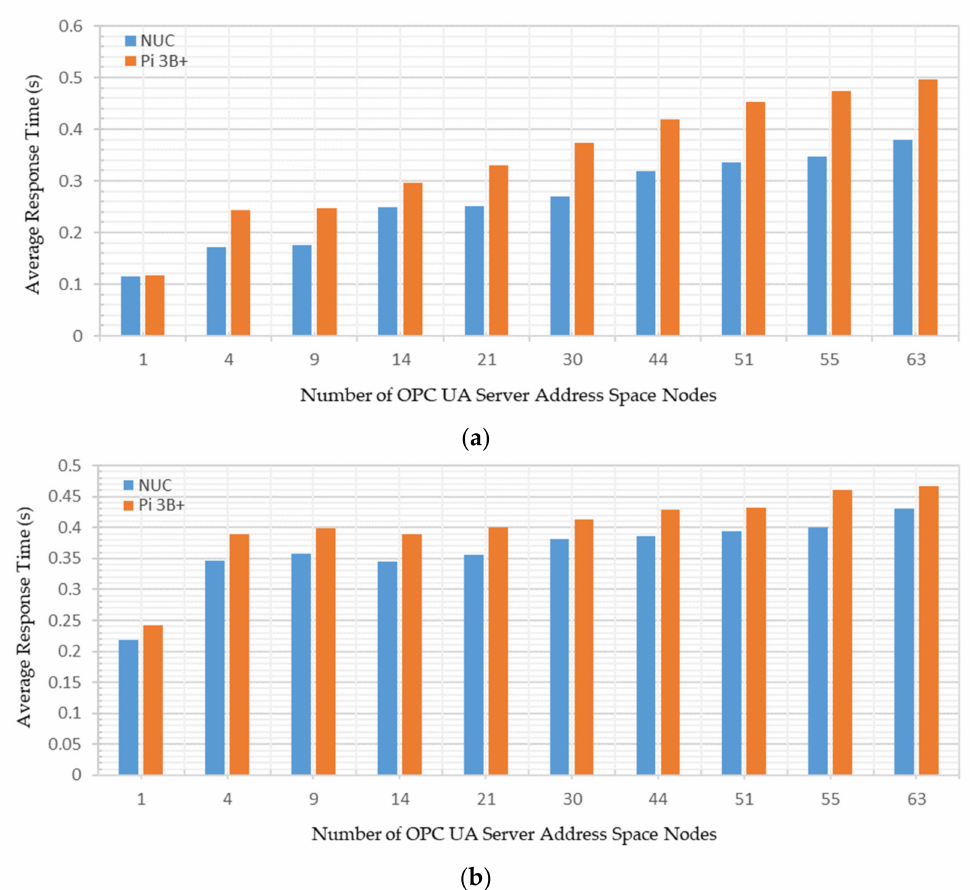
Figure 25. ( a ) Average web service response time with varying the server address space nodes; ( b ) average ThingsSentral TM cloud response time with varying the server address space nodes. From Figure 25a, averages of 0.1145 s and 0.1176 s of response time were